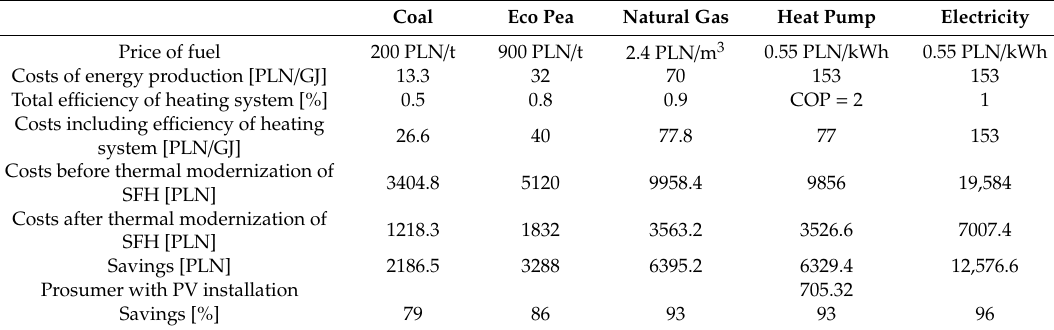
Table 3. Analysis of the heating costs of a SFH from